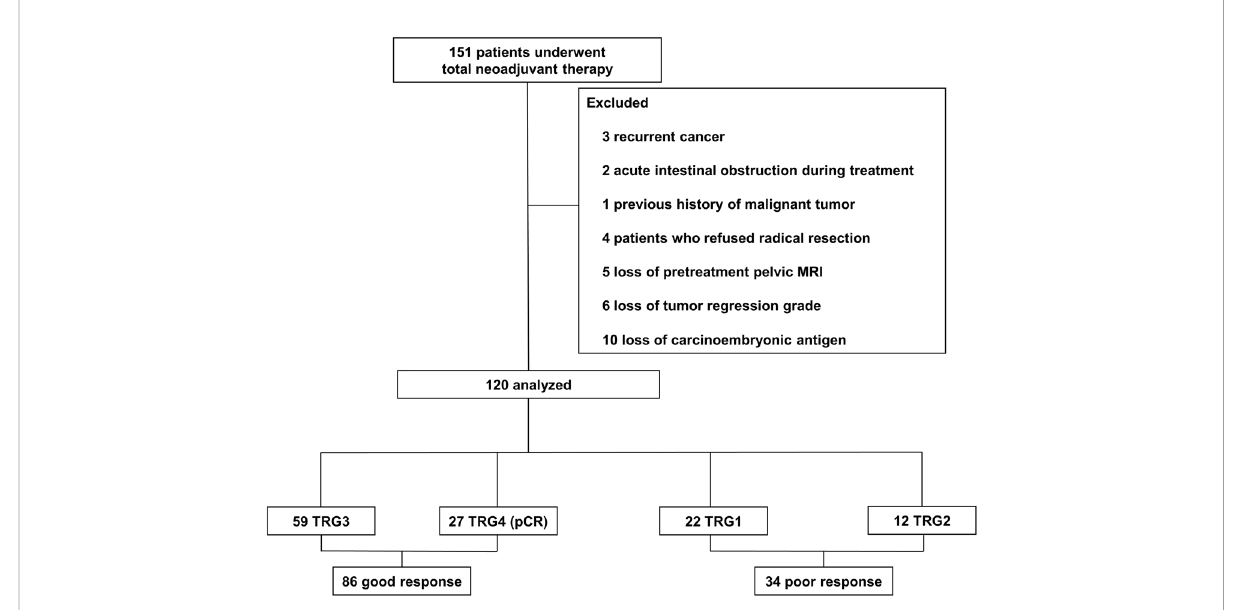
FIGURE 1 Study fl ow. TRG, tumor regression grade; pCR, pathological complete